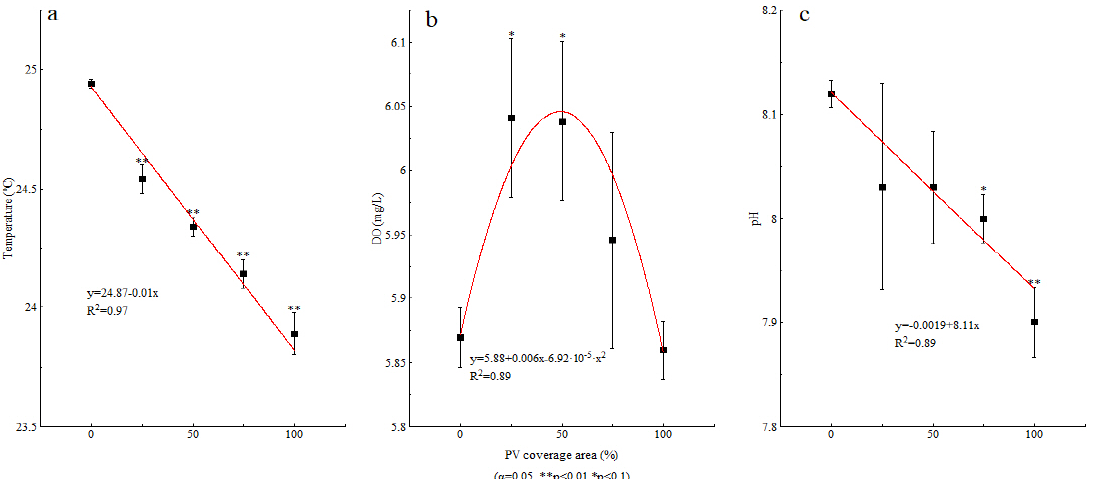
Figure 4. Relationship between PV coverage area and water temperature, dissolved oxygen and pH. ( a ) Temperature changes under different PV coverage area, ( b ) Dissolved oxygen changes under different PV coverage area, ( c ) pH changes under different PV coverage area.